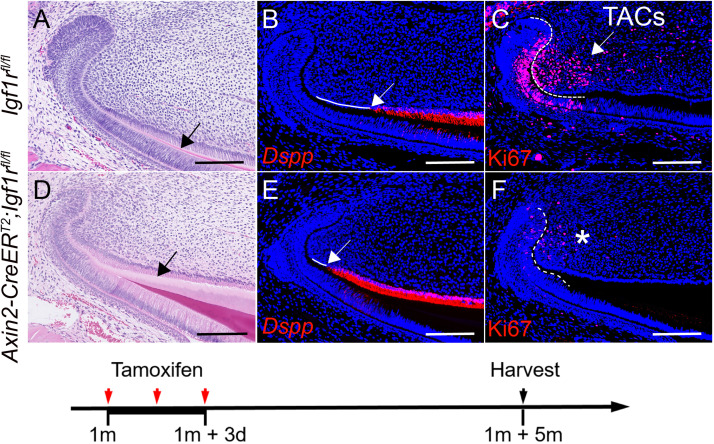
Long-term phenotype of Axin2-CreERT2;Igf1rfl/fl incisors.(A–F) H and E and RNAscope staining of Dspp (red) and Ki67 staining (red) of incisors from Igf1rfl/fl (control) and Axin2-CreERT2;Igf1rfl/fl mice 5 months after tamoxifen induction. Black arrow in A indicates normal dentin and black arrow in D indicates thicker dentin. White arrows in B and E indicate the position where odontoblasts start. White arrow in C indicates positive signal and asterisk in F indicates diminished signal. White dashed lines outline the cervical loop. Schematic at the bottom indicates induction protocol. Scale bars, 100 μm.